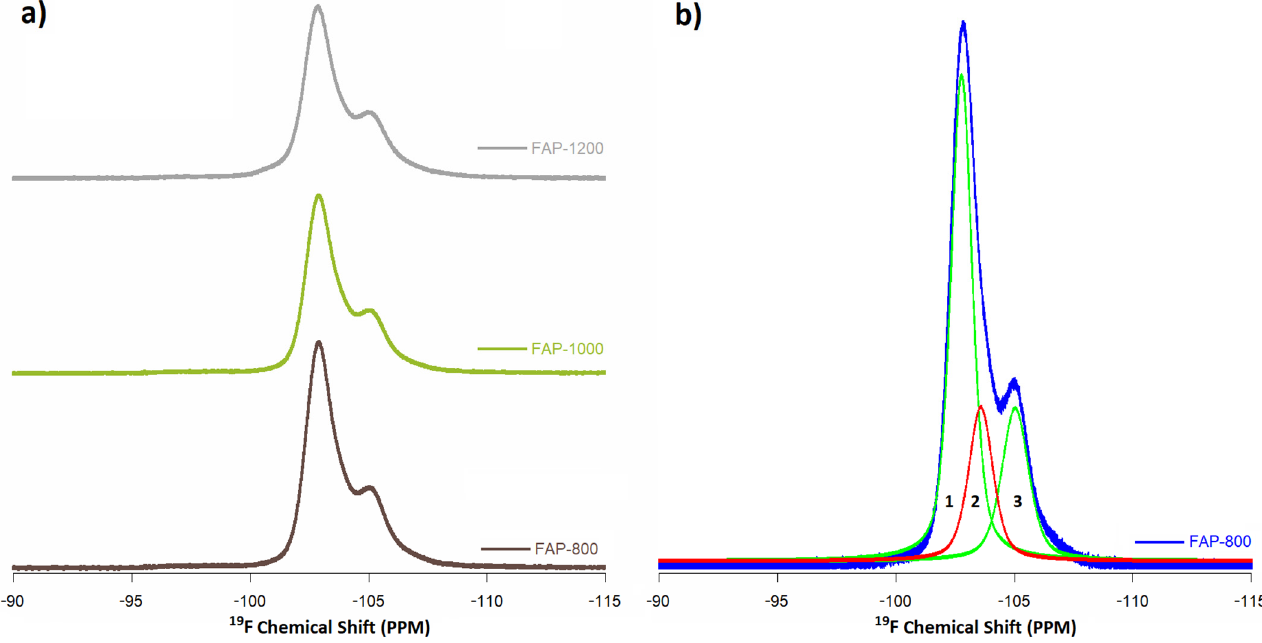
Figure 7. 19 F MAS NMR spectra of ( a ) FAP samples and ( b ) curve fitting of FAP-800 samples (1. crystalline phase, 2. apatite-like boundary layer from FOHAP, 3. amorphous phase).